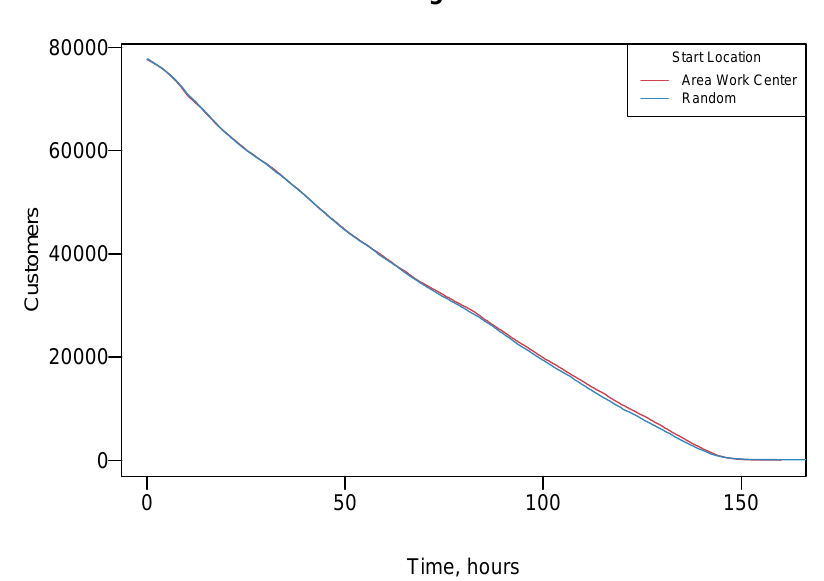
Figure 7. Start location for simulated large storms with 5000 outages. Crew start location varied as indicated. Travel speed set to 25 mph, 272 crews with 85% working during day shift, 99% working during evening shift and 66% working during night shift, 1 to 10 h repair time range and nearest outage search strategy. ETR curve was insensitive to crew start